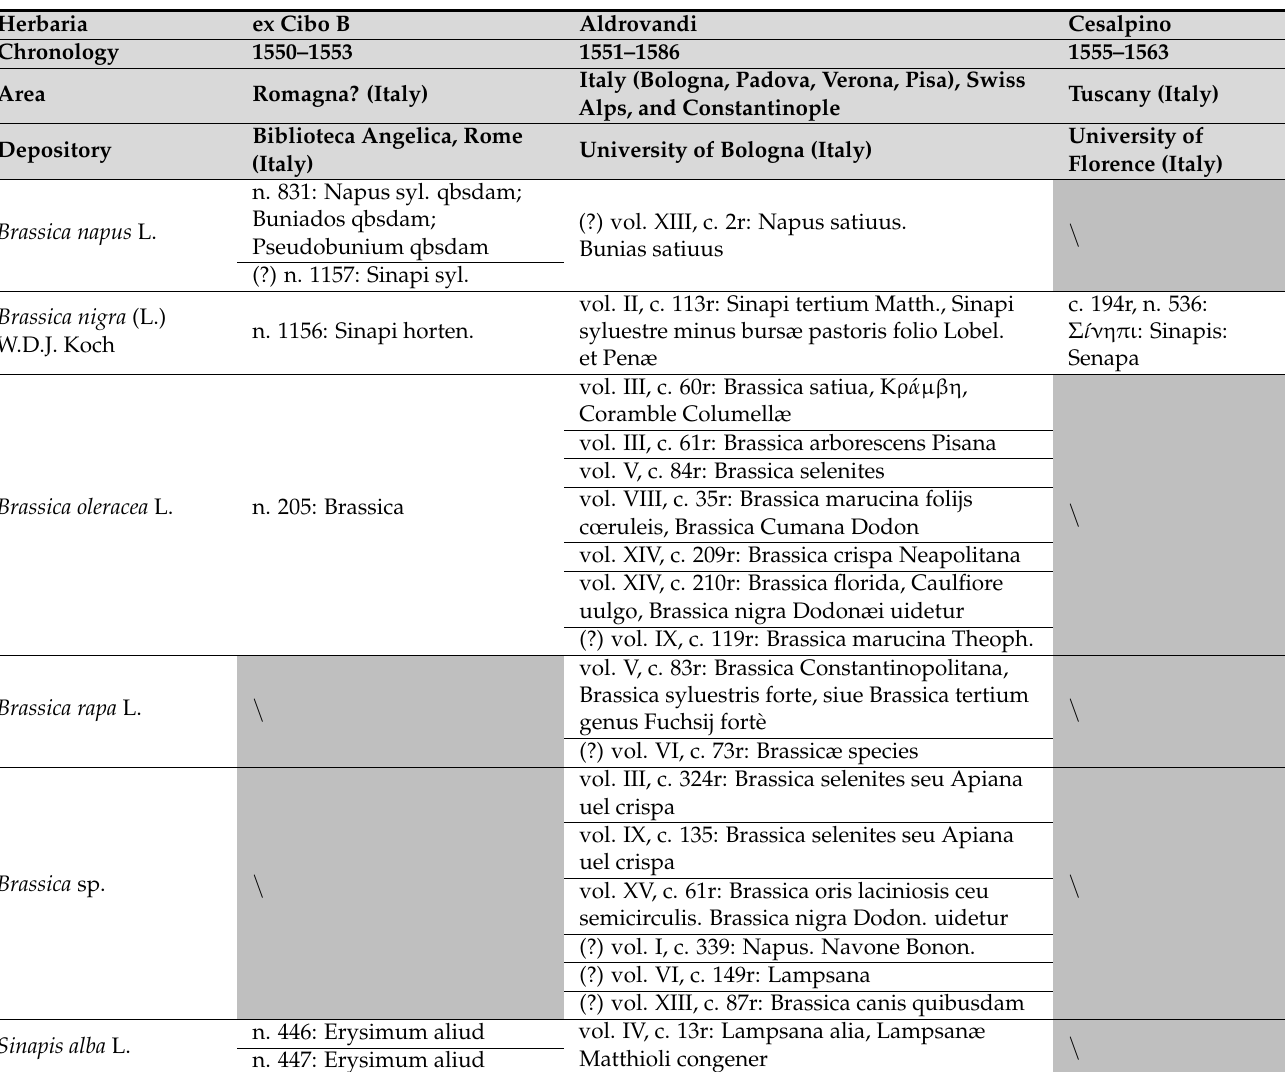
Table 4. Synopsis of the specimens of Brassica and Sinapis species found in the Italian Renaissance herbaria. The identification and the attribution to a currently accepted species follow [41–46,48]; nomenclature is updated according to [49]. The question mark within brackets indicates a doubtful identification ( Brassica cfr. napus